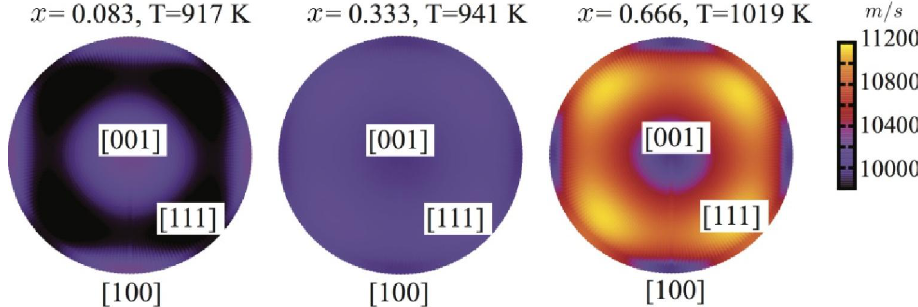
Figure 7. Calculated longitudinal sound velocity anisotropy map and Debye temperatures for c-Ti Al N at different functions x of AlN. The surface plots show the calculated 1−x x spherical distribution (θ,φ) of the longitudinal sound velocity from top view assigned by high symmetry